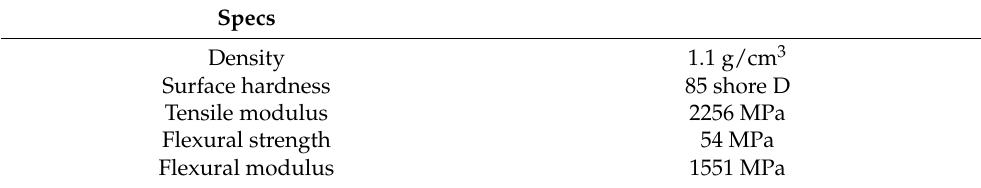
Figure 3. Schematic representation of a top view of the fabrication process. ( a ) Printing the whole structure, ( b ) applying silver conductive paint on the tube to provide a conductive track for applying the actuation current, and ( c ) copper plating on the surface of the tube to reduce the resistance of the conductive track. Table 1. Properties of the 8k grey resin [25].